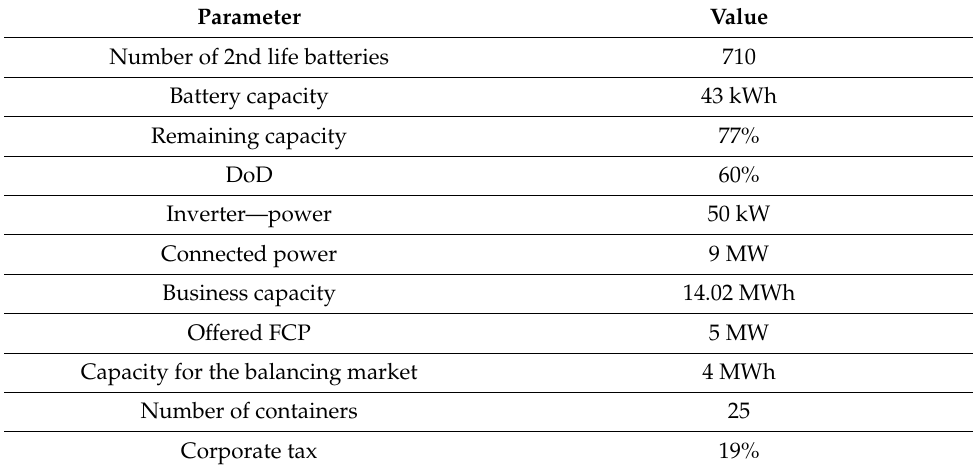
Table 11. Output investments.